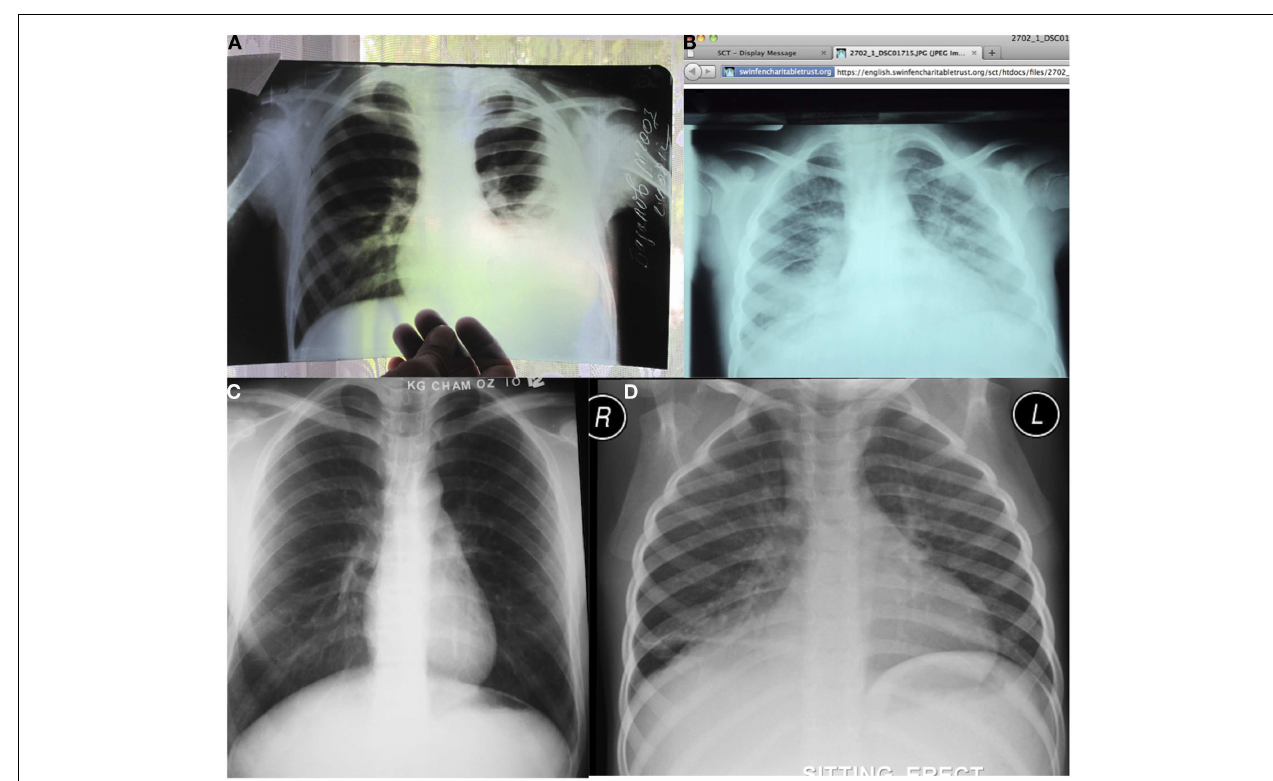
the vascular crowding, again due to under inspiration. (C) A radiograph referred from an MSF site in Cambodia is of higher quality, probably owing to the digital equipment available, which also avoids the quality losses from photographing or scanning hard copies. Note that positioning quality is improved with older patients but that on this occasion the right costophrenic angle has been cut off. (D) A digital X-ray referral from Khayelitsha District Hospital involves direct conversion of a DICOM image to JPEG for limiting file size and e-mailing through a control telereader to an expert pediatric radiologist. On this radiograph, a right lower lobe air-space disease process was reported but there were no features identified to suggest tuberculosis. The radiographic quality and labeling is excellent, as there are professionally trained radiographers working